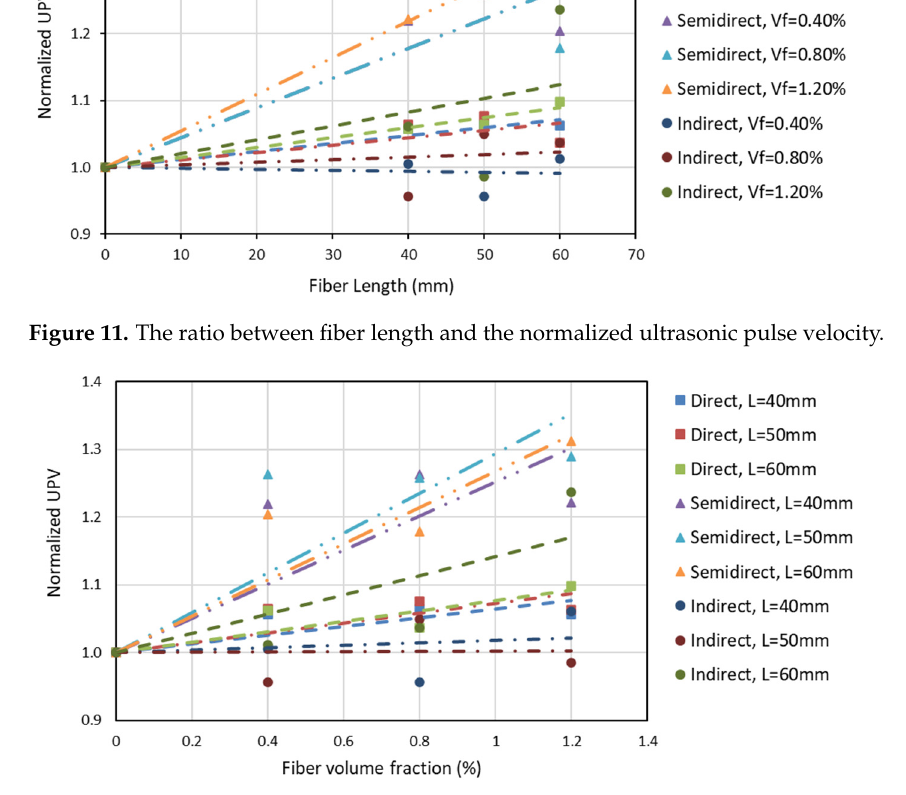
Figure 12. The ratio between the fiber volume fraction and the normalized ultrasonic pulse velocity.